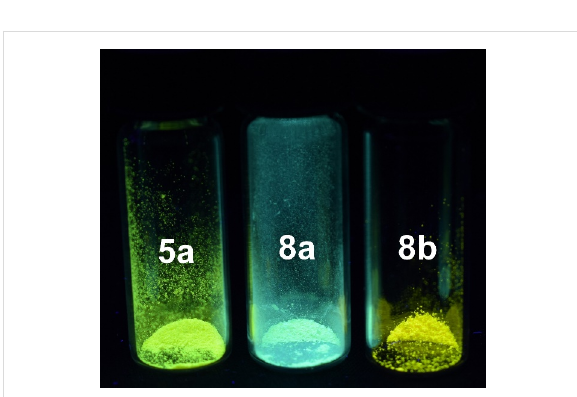
Figure 7: Solid-state luminescence of 1 H -pyridines 5a , 8a and 8b ( λ exc = 365 nm).